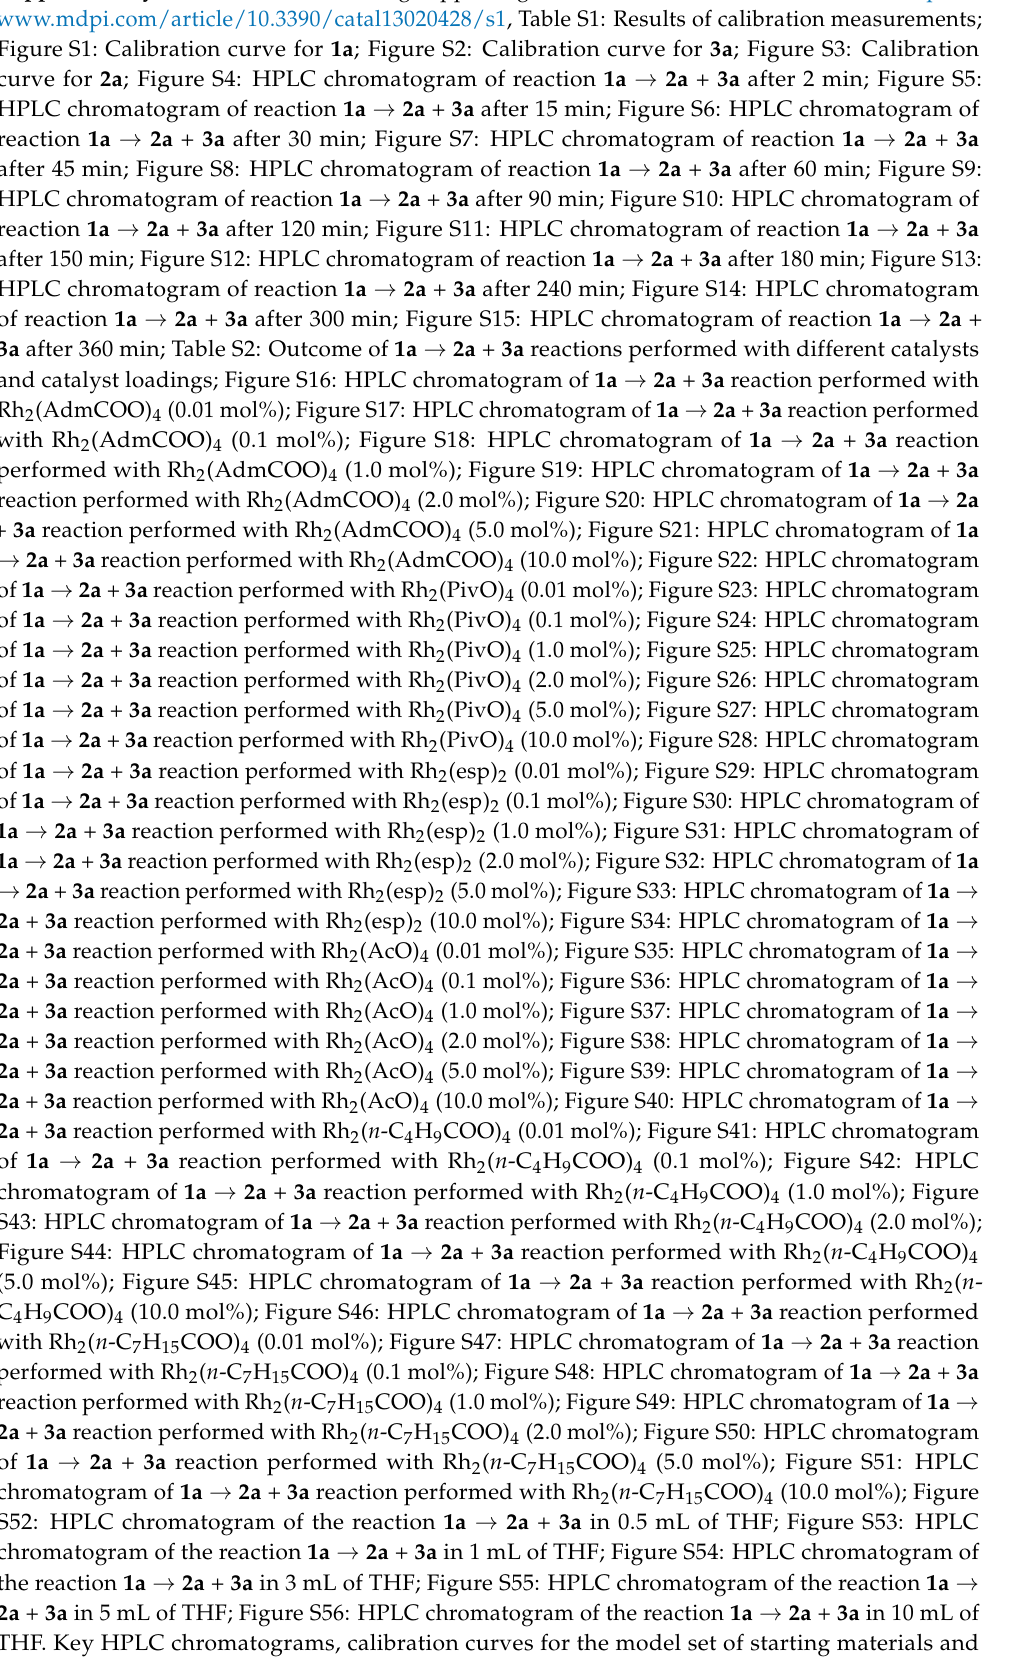
S52: HPLC chromatogram of the reaction 1a → 2a + 3a in 0.5 mL of THF; Figure S53: HPLC chromatogram of the reaction 1a → 2a + 3a in 1 mL of THF; Figure S54: HPLC chromatogram of the reaction 1a → 2a + 3a in 3 mL of THF; Figure S55: HPLC chromatogram of the reaction 1a → THF. Key HPLC chromatograms, calibration curves for the model set of starting materials